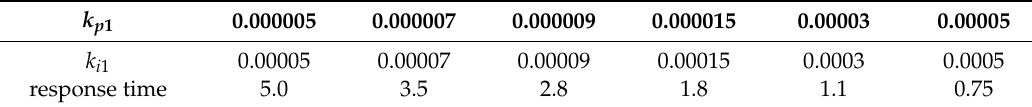
Table 2. Response time of step signal under different PI parameters.